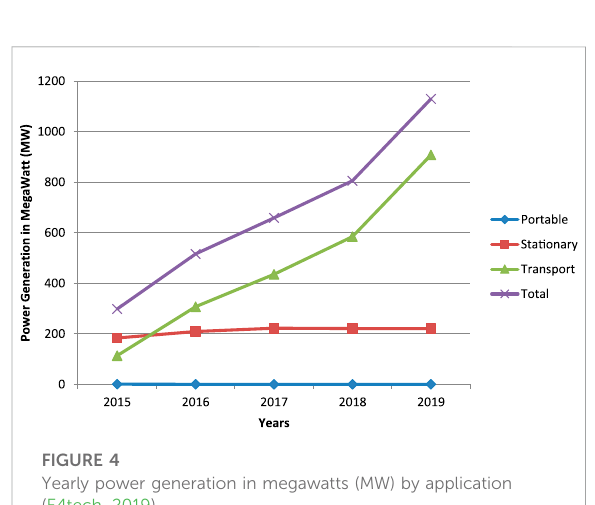
FIGURE 3 Yearly fuel cell ’ s production (1000 units) by application (E4tech, 2019).